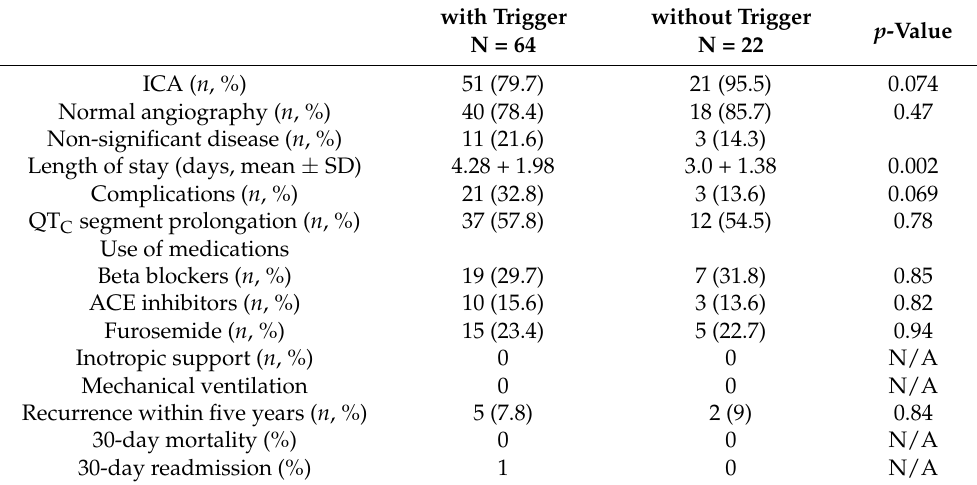
Table 5. Outcomes during the index hospitalization and 30-day